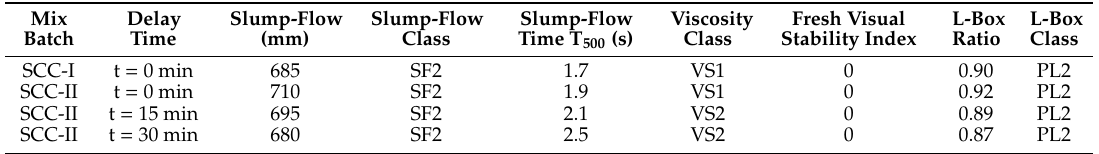
Table 2. Fresh property test results.